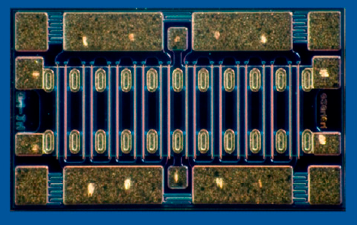
Figure 1. Photograph of a GaN high-electron-mobility transistor (HEMT) bare die (CGH60030D) from Wolfspeed. Table 1. Device parameters of CGH60030D.